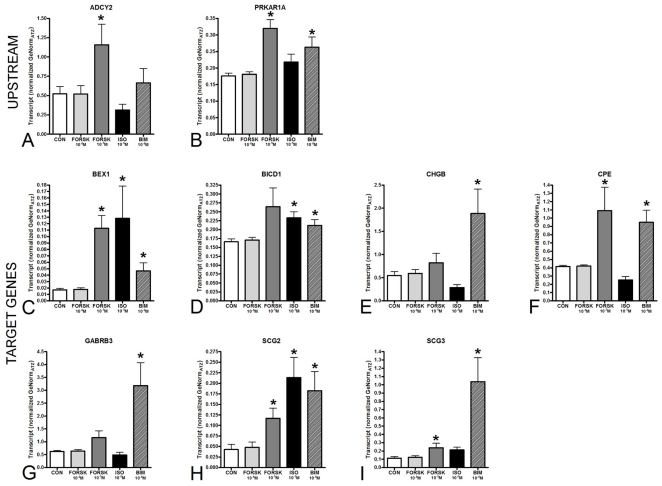

In vitro assessment of ADCY2, PRKAR1A, and CREB response elements transcripts.
ADCY2 responded to cAMP activator forskolin (10−5 M: 220%) (3A), while PRKAR1A was stimulated by forskolin and dopamine D2 and 5-HT2 receptor agonist BIM-53061 (10−6 M) (188% and 153% respectively) (3B). BIM-53061 was a universal CRE activator, while forskolin had a less pronounced effect (3C–I). The selective ß-adrenergic receptor agonist isoproterenol (10−5 M) stimulated transcription of BEX1, BICD1, SCG2 and SCG3. Forskolin (10−6 M) had no effect. *p<0.05 vs. CON. MEAN±SEM (n = 6).